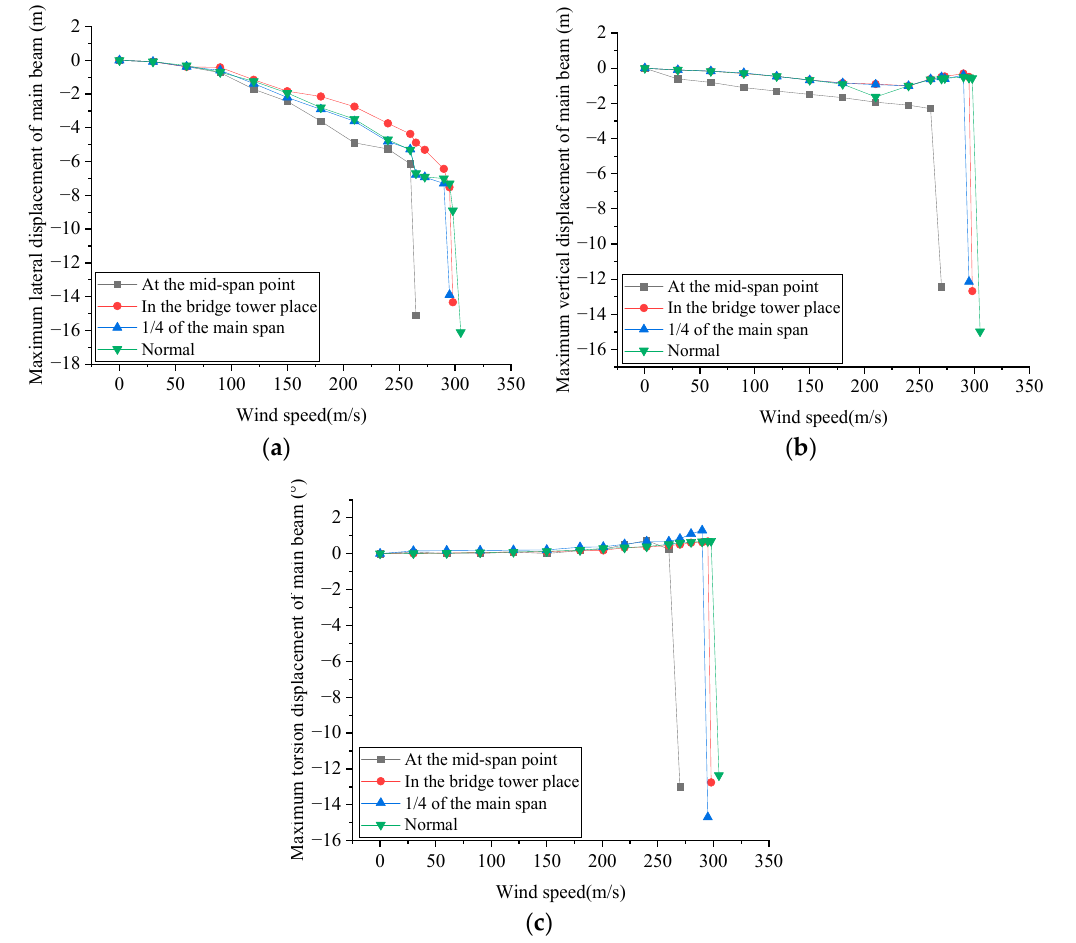
Figure 16. Maximum displacement curve of main beam with wind speed under different broken positions of the stay cable; ( a ) Lateral displacement; ( b ) Vertical displacement; ( c ) Torsion angle.